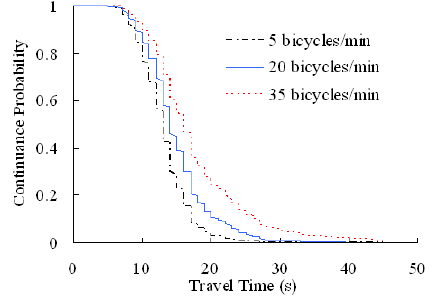
Fig. 4. Distributions of the continuance probability with different non-motorized vehicle